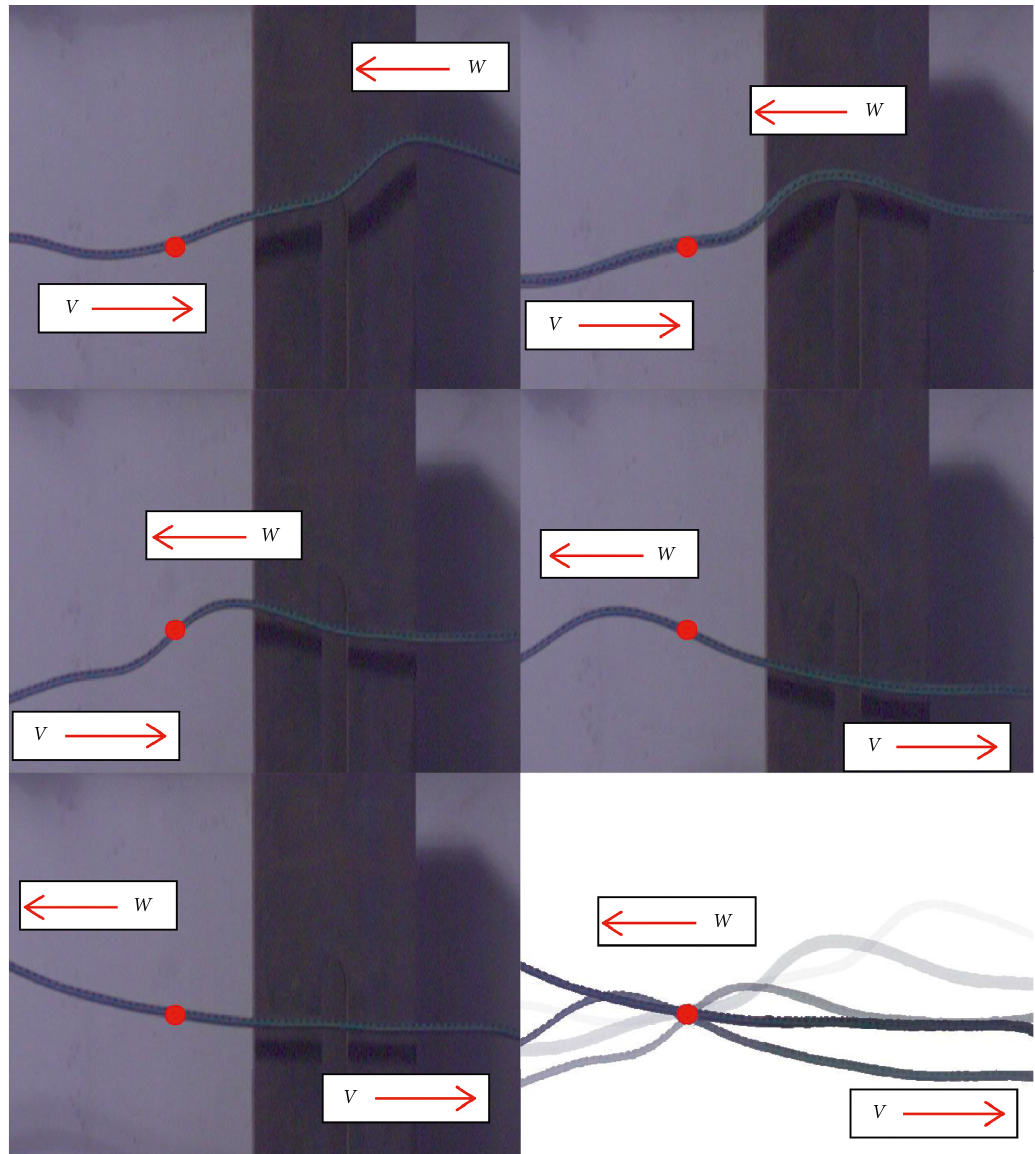
Figure 3: Snapshots recorded by a high-speed camera for an axially moving string. The red point is one node. The last picture is a compound one drawn from preceding snapshots. V denotes the transport speed and W denotes the backward travelling wave speed. Their directions are